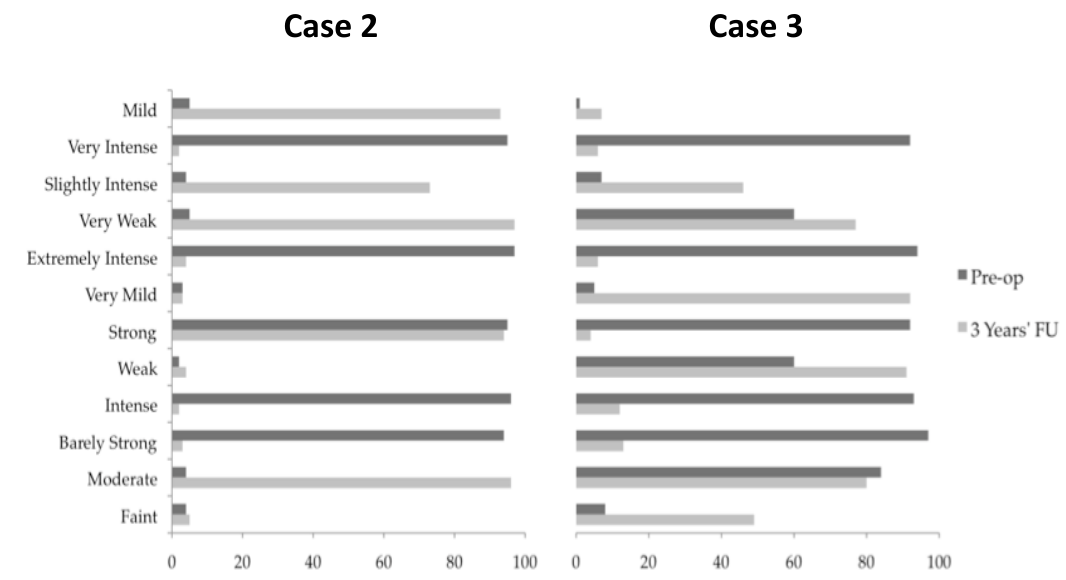
Figure 3. Pre-operative and post-operative Descriptor Differential Scale (DDS) [43] for Cases 2 and 3. Pre-operative and post-operative DDS measurements were performed for Case 2 and Case 3. Patients were asked to mark along each line the extent to which the description applies to their symptoms between 0 and 100. Single electrode dual target dual stimulation at 3 years follow-up decreased the severity of pain consistently in patients 2 and 3 compared to pre-operative assessments. Post-operative DDS measurements were not available for Case